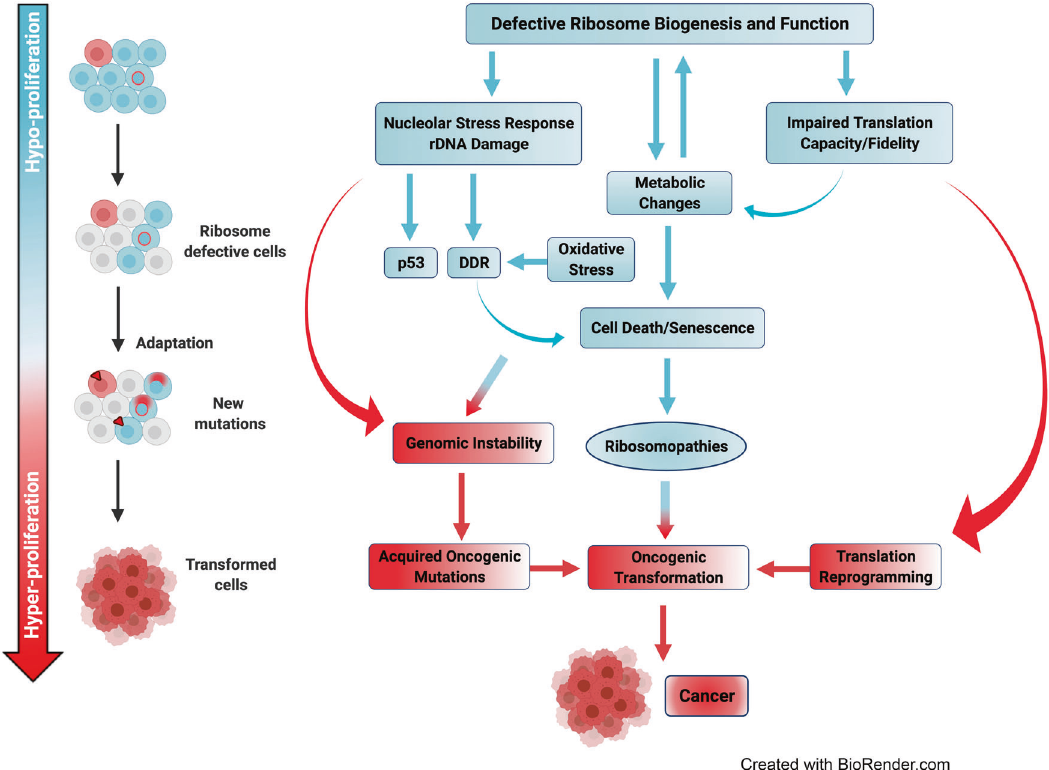
Fig. 5 A model of the transition from cellular hypo-proliferation to hyper-proliferation in ribosomopathies. Defects in ribosome biogenesis and ribosome function induce p53 activation via the nucleolar stress response, but also activate the p53-independent DNA damage response (DDR). Defects in ribosome biogenesis also result in the selective translation of subsets of mRNAs involved in the regulation of cellular metabolism. In turn, deregulation of metabolism leads to oxidative stress that further impairs ribosome biogenesis and ribosome function. These nucleolar and metabolic stresses result in hypo-proliferative responses including cell cycle arrest, senescence or apoptosis that parallel the hypo-proliferative phenotypes associated with ribosomopathies. Chronic deregulation of ribosome biogenesis and cellular metabolism promotes genomic instability and secondary mutations, leading to the outgrowth of clones harboring translationally driven elevated metabolism and pro-survival mechanisms that underpin the transition from hypo-proliferation to hyper-proliferation phenotypes and cancer predisposition in